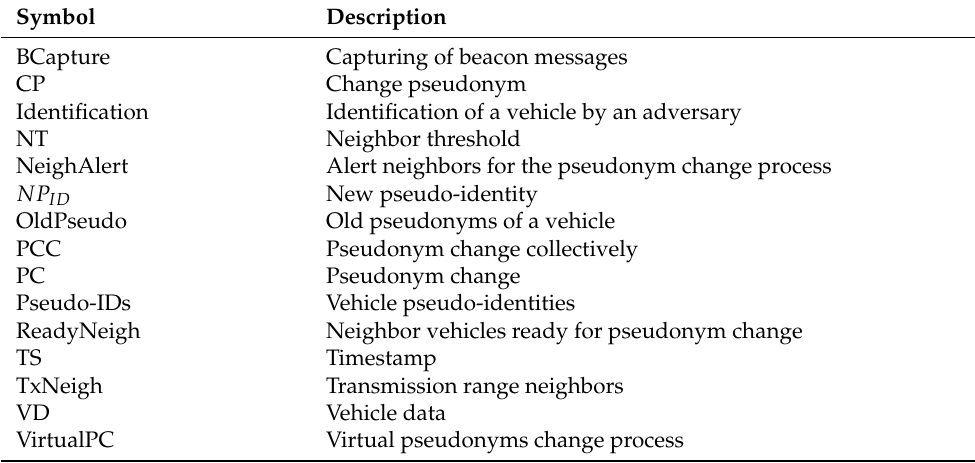
Table 4. Symbols used in HLPN for attacker scenario in DGVP scheme.